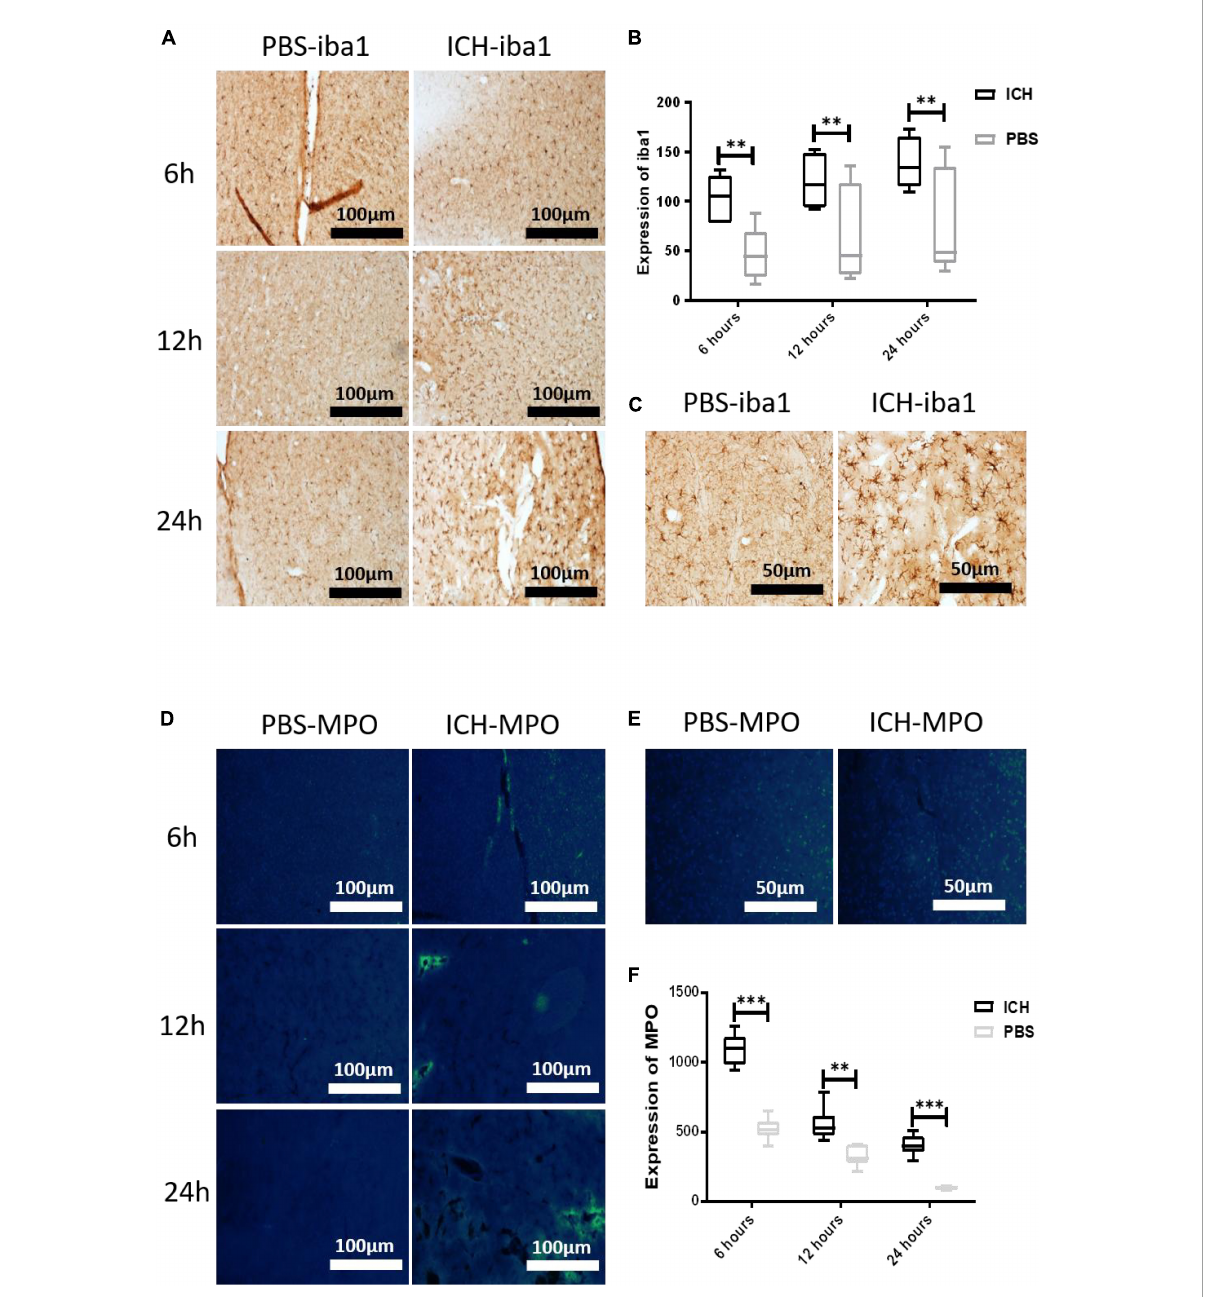
FIGURE4 Microglia and MPO were activated following ICH. (A) Immunohistochemistry of the PBS and ICH groups at 6, 12, and 24 h post-injury. The labeled molecule was iba1 (10 × , 20 × ); (B) statistics of iba1 positive expression (** P < 0.01, n = 6 in each group); (C) immunohistochemistry of iba1 in the PBS and ICH groups at 24 h post-injury (10 × , 40 × ); (D) immunofluorescence of MPO in the PBS and ICH groups at 6, 12, and 24 h post-injury (10 × , 20 × ); (E) immunohistochemistry of MPO in the PBS and ICH groups at 6 h post-injury (10 × , 40 × ); (F) statistics of MPO molecular expression (** P < 0.01, *** P < 0.001, n = 6 in each